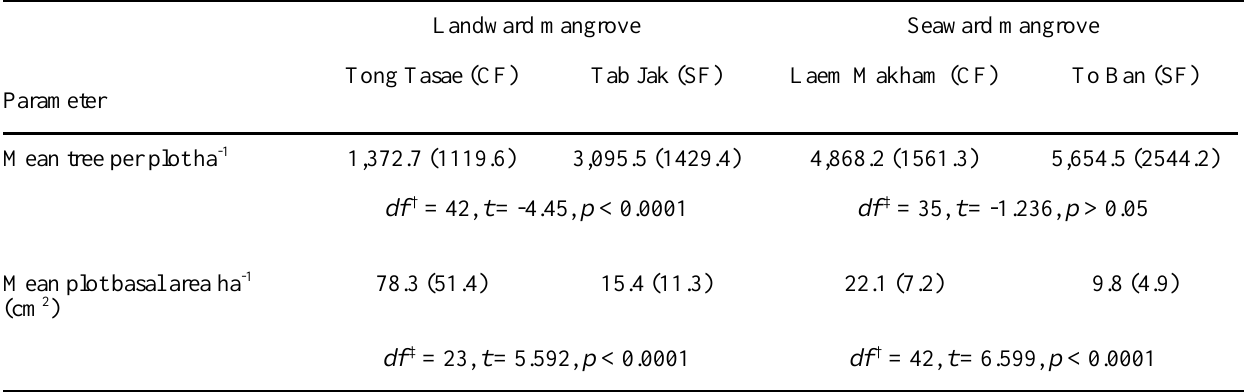
Table 7. Differences in mangrove tree density and basal area across community-managed (CF) and state- managed (SF) mangrove forests in Trang, southern Thailand. N = 22 plots for each forest. Statistical test results are for a t -test, †: equal variances; ‡: unequal variances.